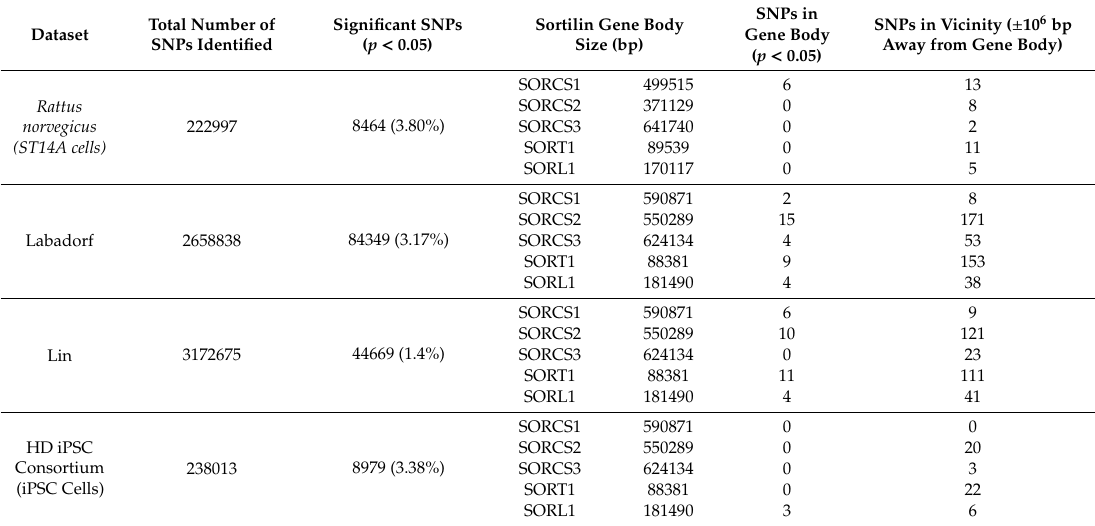
Summary of SNP variants detected in rat and human through genome analysis toolkit / genome-wide association study (RNA-Seq GATK / GWAS) pipeline. DNA variants identified in the gene body and in regulatory vicinity regions are